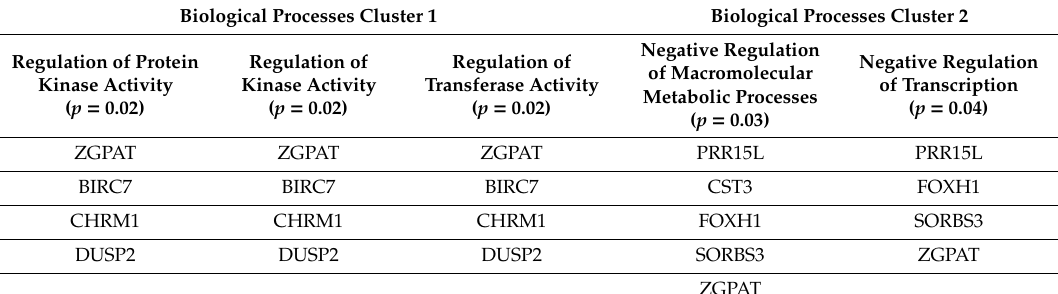
Table 4. DAVID clustering of biological processes of iM-forming genes with three or more 5hmCs within a G4 / iM-forming sequence upstream relative to TSS. The statistical significance of these processes being enriched versus random gene selection is indicated by the p value shown.